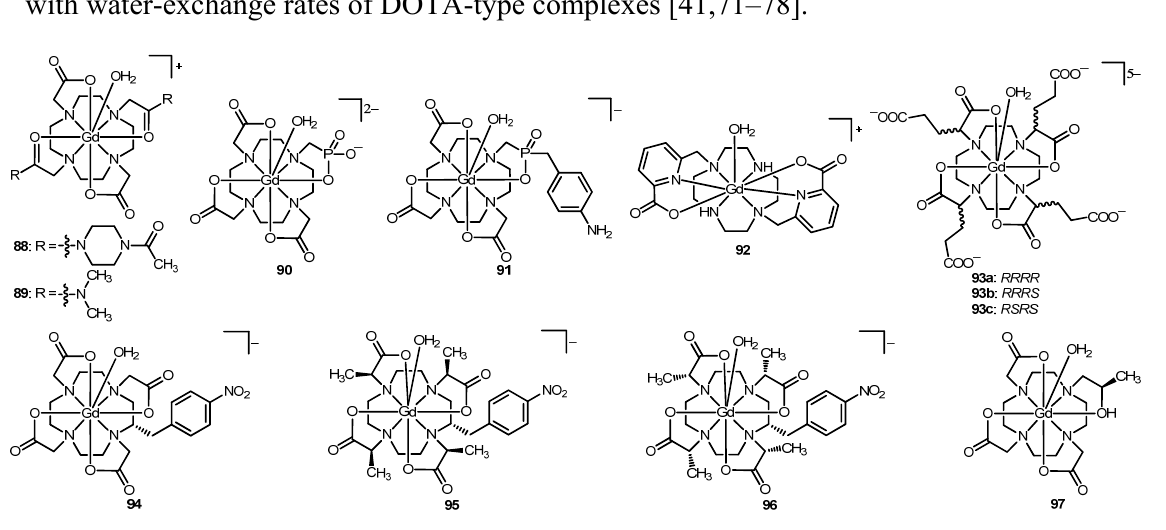
Figure 8. Representative complexes 88 – 97 that relate the influence of TSAP/SAP ratios with water-exchange rates of DOTA-type complexes [41,71–78].